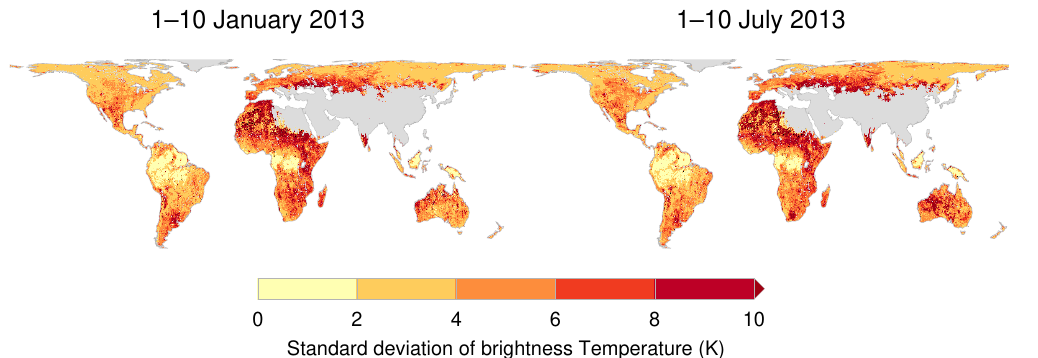
Figure 5. Ten-day averaged standard deviations from 500 conditional random samples per day between 1–10 January 2017 ( left ) and 1–10 July 2017 ( right ), respectively.